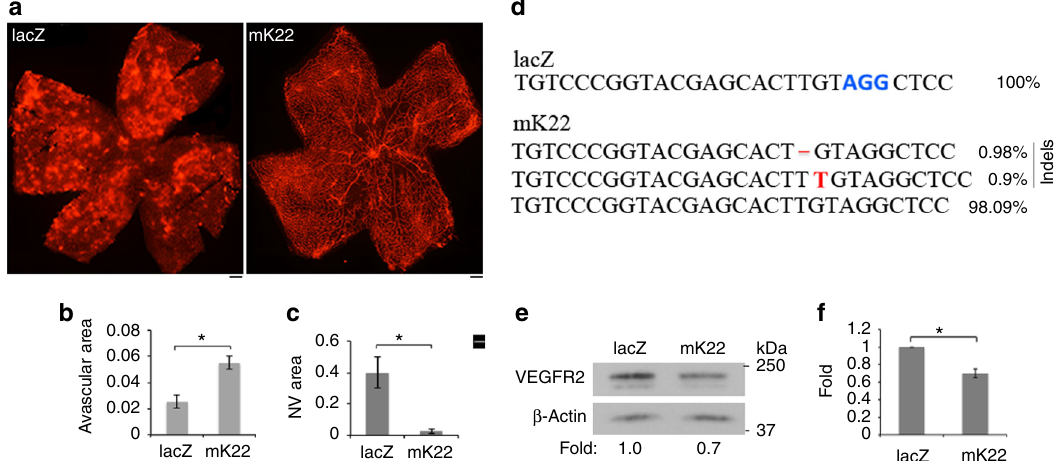
Fig. 3 Editing genomic VEGFR2 abrogated hypoxia-induced angiogenesis. a Litters of P12 mice that had been exposed to 75% oxygen for 5 days were injected intravitreally with 1 μ l (3.75 × 10 12 vg/ml) containing equal rAAV1-SpCas9 and rAAV1-lacZ (lacZ) or rAAV1-mK22 (mK22). On P17, whole-mount retinas were stained with IB4. lacZ and mK22 indicate retinas from the rAAV1-SpCas9/lacZ and mK22-injected mice, respectively. b Analysis of avascular areas from the IB4-stained retinas ( n = 6). c Analysis of NV areas from the IB4-stained retinas ( n = 6). d NGS analysis of indels. The DNA fragments around the PAM sequences were PCR ampli fi ed from genomic DNA of the rAAV1-SpCas9/lacZ or -mK22-injected retinas, and then subjected to NGS. e , f The lysates of the rAAV1-SpCas9/lacZ or -mK22-injected retinas were subjected to western blot analysis using indicated antibodies. The bar graph data are mean ± SD of three retinas. “ * ” indicates signi fi cant difference using an unpaired t -test. p <